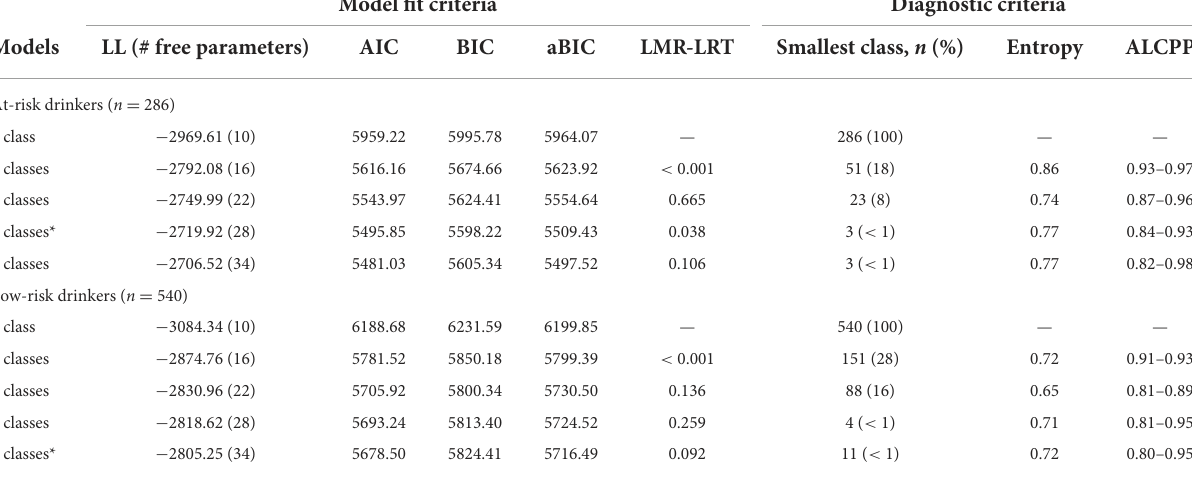
TABLE 1 Model fit and diagnostic criteria for alternative trajectory models for the control group separately for at-risk drinkers and low-risk